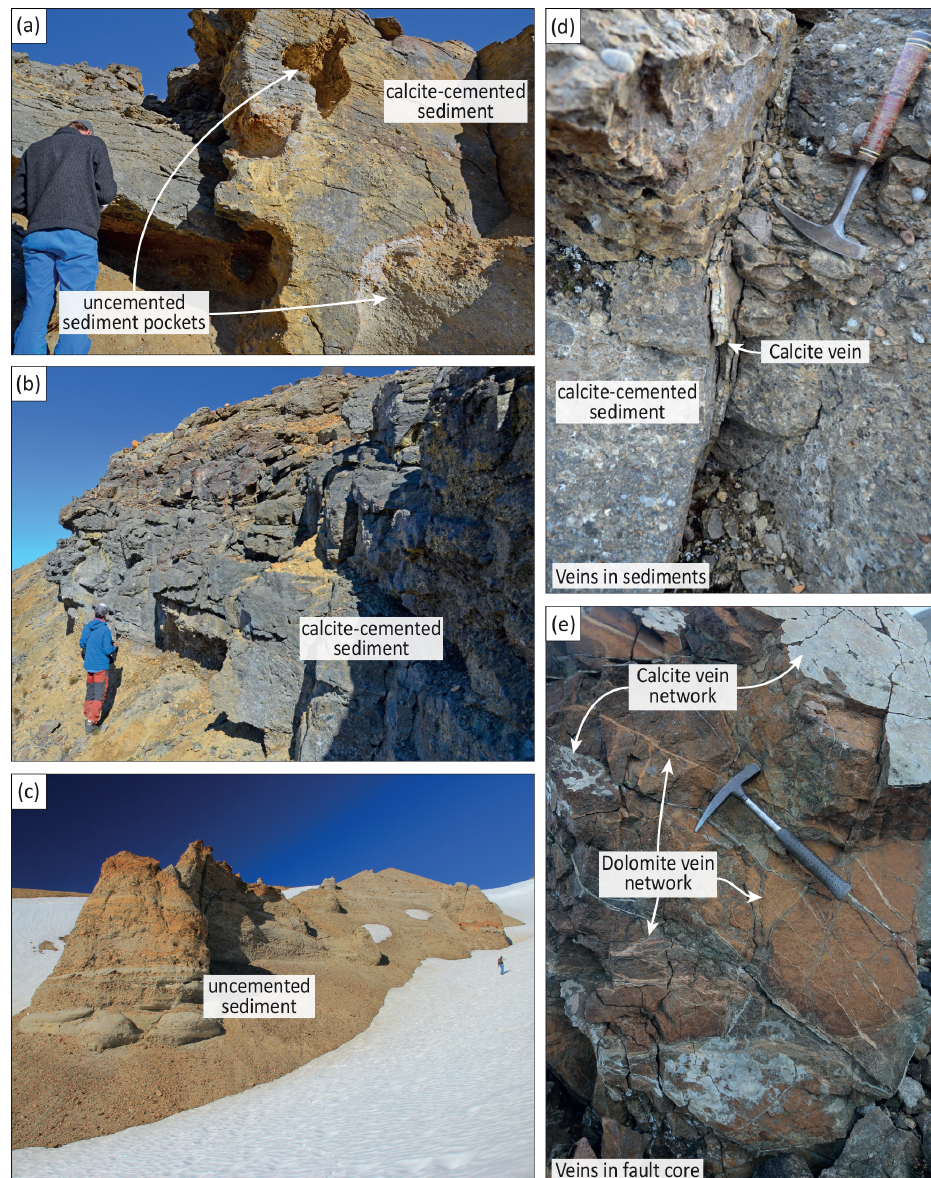
Figure 3. (a) Calcite-cemented sandstone with uncemented pockets at the distal end of the cementation zone; (b) calcite-cemented conglom- erate at distal end of the cementation zone; (c) uncemented sandstone/conglomerate outside the cementation zone; (d) calcite vein cutting through calcite-cemented sandstone within the cementation zone; (e) dolomite vein network (yellowish) cut by younger calcite vein network (whitish) within Dombjerg Fault core. For the locations of photos, see Fig.